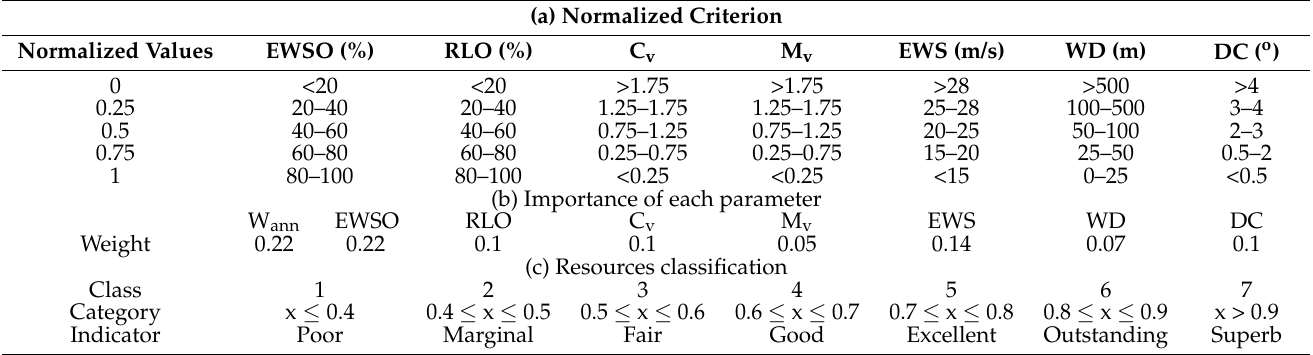
Table 3. Classification of the wind energy resources involving multiple parameters. Results processed from (a) to (c) according to Costoya, et al.